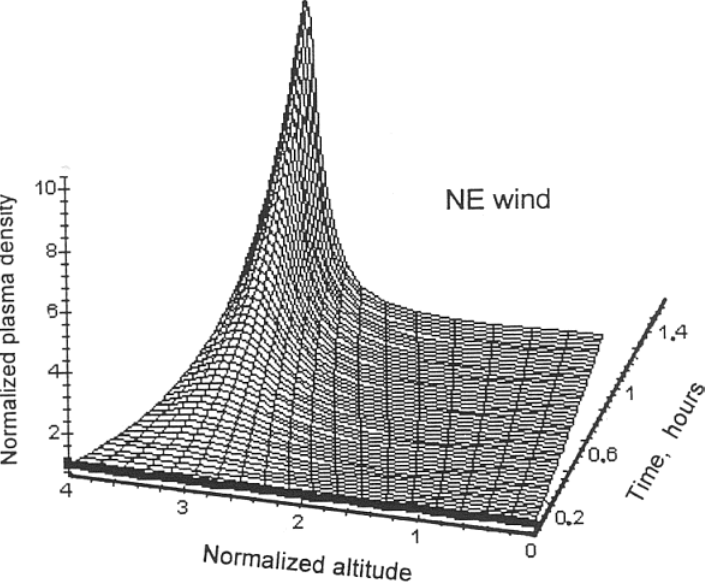
Fig. 6. Same as Fig. 5 but for the north- east PW vortex quadrant, i.e. the profile is representative of PW winds pointing NW. A well-defined broad layer forms near 110km.